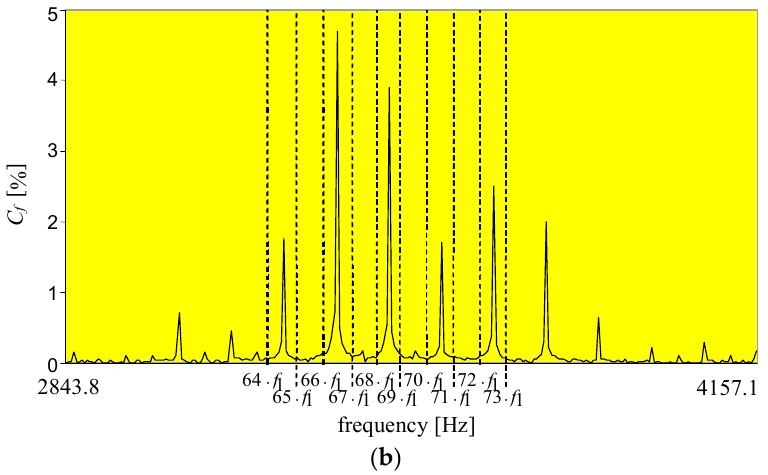
Figure 4. Exemplary waveform of supply voltage; ( a ) the analysed frequency sub-band is marked with yellow; the dashed line marks the frequency of the 50th harmonic whereas the dotted line marks the frequency of the 100th harmonic; ( b ) the extended frequency sub-band 2843.8–4157.1 Hz is marked with yellow; the dashed lines mark the harmonic frequencies as integer multiples of the fundamental frequency equal to 50.51 Hz [1]. C f is the content of higher frequency components in relation to fundamental voltage, both: harmonics and interharmonics.